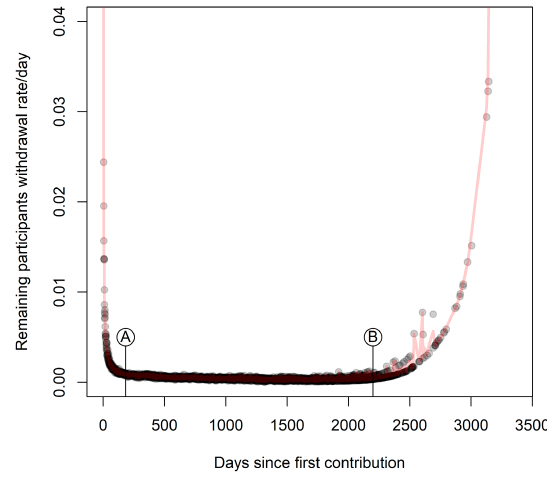
Figure 4. Hazard function of OSM participants, where dark dots are the proportion of remaining participants who withdrew at a given time and the red line is a moving average of the data. The first and last points of the distribution are not shown. Tags A and B delimit a segment of the curve where withdrawal rates are low and almost constant.